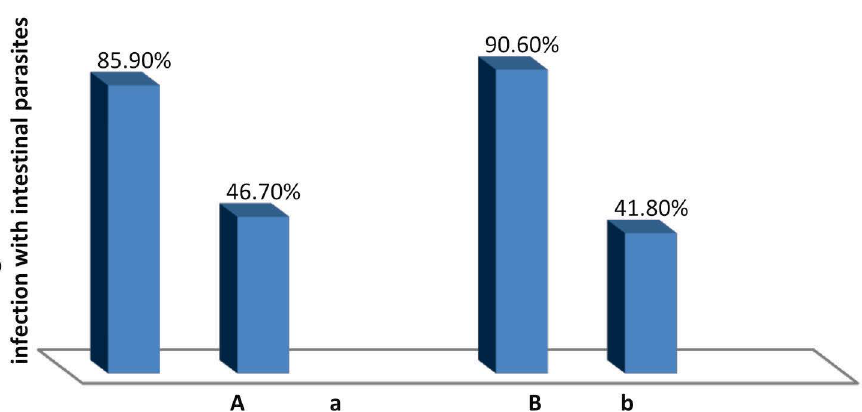
Fig. 1. Percentage of infection with intestinal parasites in hospitals comparison with closed markets of its. A: The markets of AL- Nassiriyah; a: Nassiriyah Maternity and Children hospital and Nassiriyah general hospital; B: The markets of Suq – AL- Shuyukh; b: Suq-AL-Shuyukh general hospital;